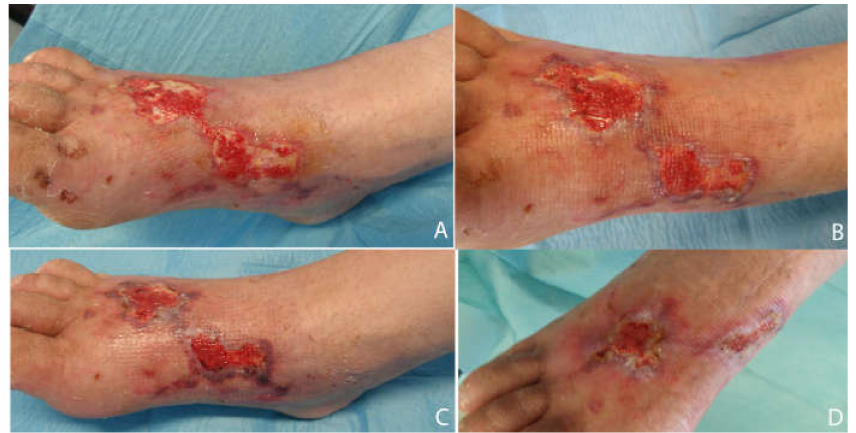
Figure 6. Diabetic case. AA, 58 y/o. Presence of periwound inflammation sign and Class 3 periwound tissue by HPS classification. Appearance of the wound before the treatment ( A ). Wound aspect after 2 weeks ( B ). Wound aspect after 4 weeks ( C ) and final aspect with partial reepithelialization after 8 weeks ( D ).